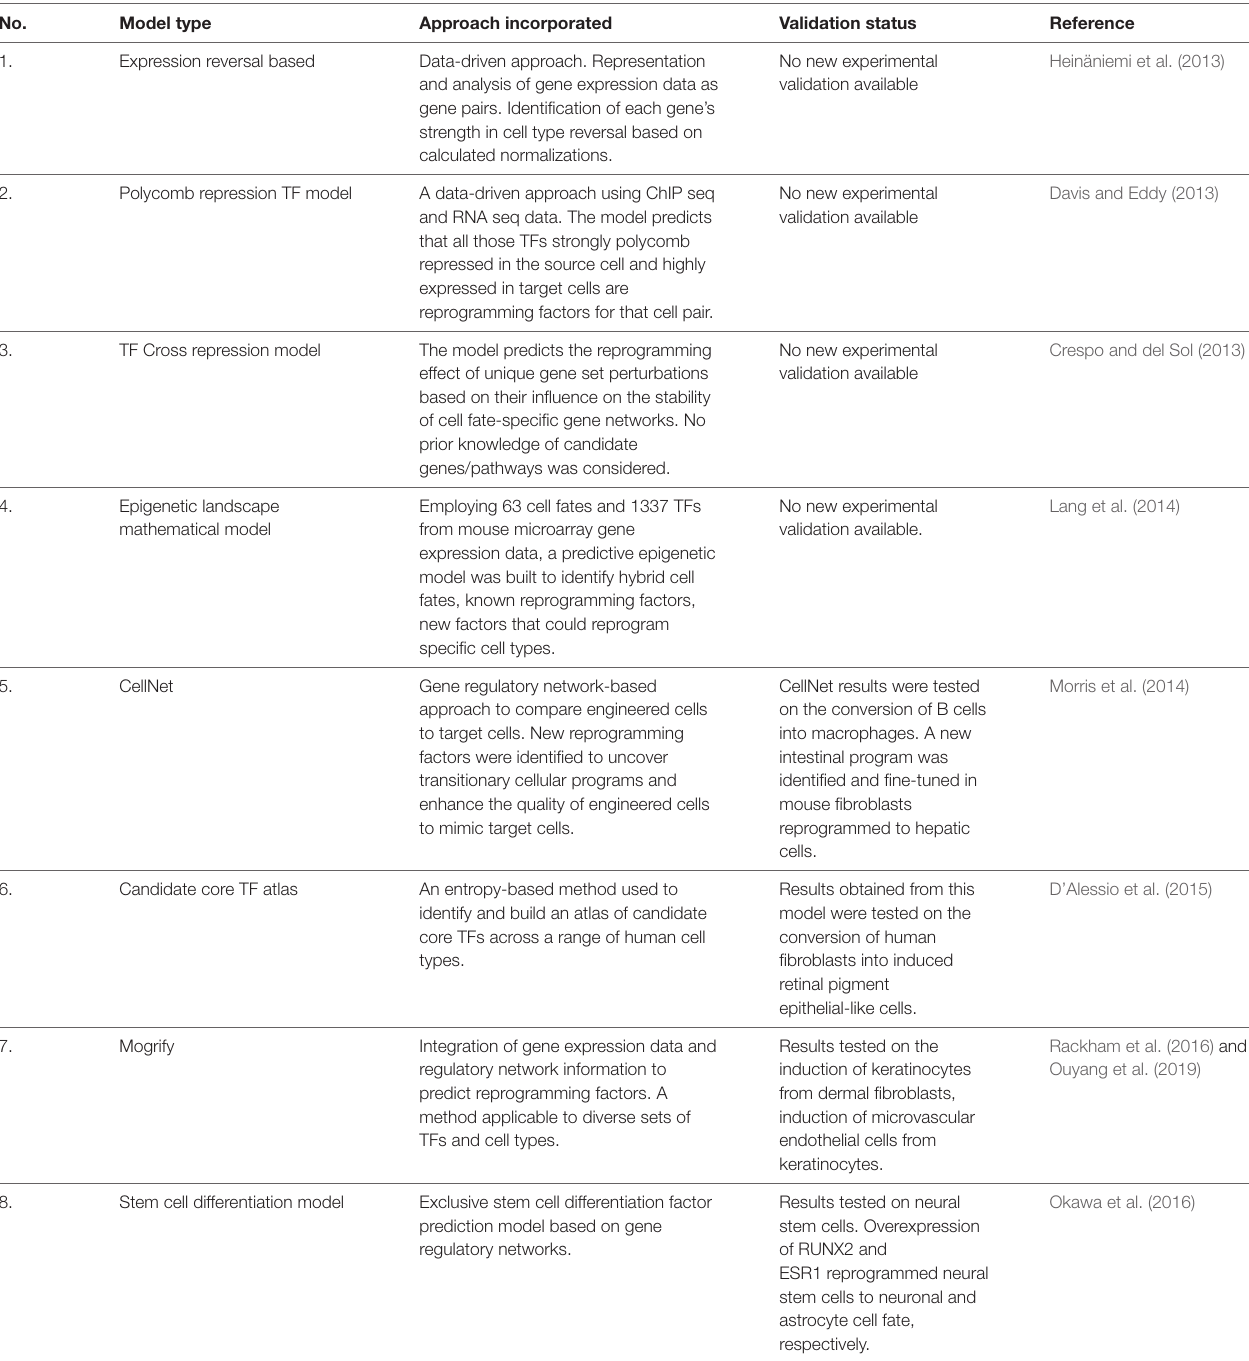
TABLE 1 | Computational approaches developed to predict transcription factor/s (TF) suitable for reprogramming one somatic cell type to